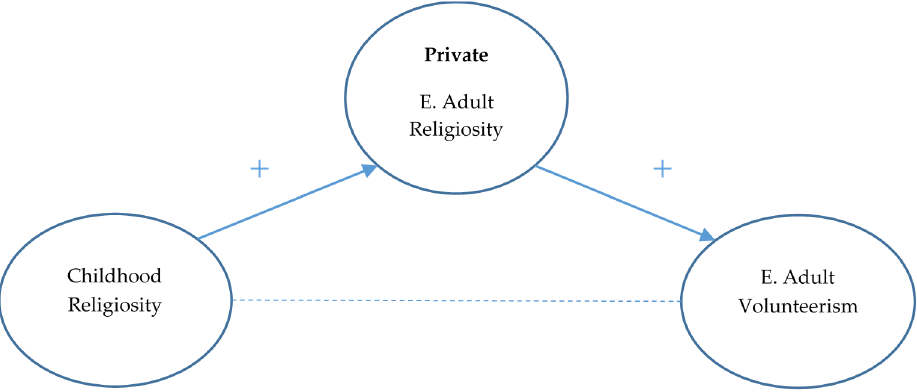
Figure 1. Mediating effects of private emerging adult religiosity on rates of volunteerism.